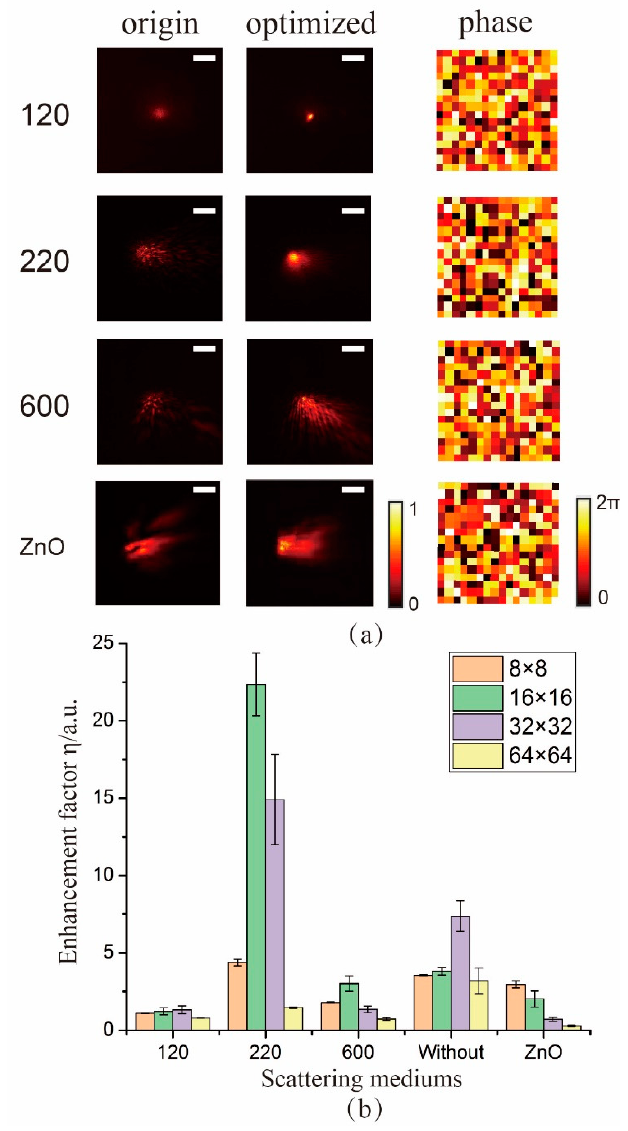
Figure 4. The enhancement of SHG with different scattering mediums using wavefront shaping technique (results from the statistical average values of multiple experimental data). ( a ) The second harmonic light field before and after optimization of different scattering mediums. ( b ) Statistical histogram of the second harmonic intensity enhancement factor corresponding to different scattering mediums with different resolutions. Note: the optimized light field is collected after three times attenuation. Scale bar: 1.468 mm.